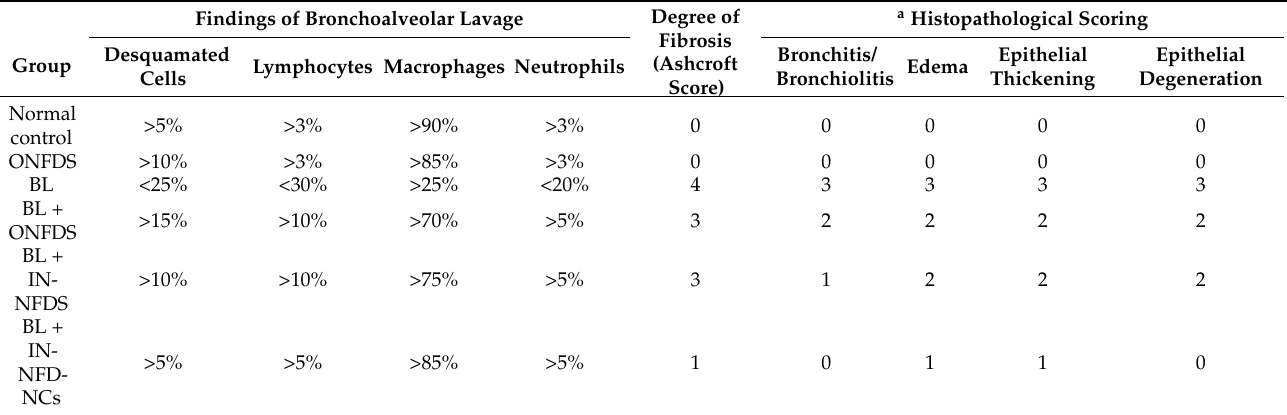
Table 8. The findings of bronchoalveolar lavage, degree of fibrosis (Ashcroft score) and histopathological scoring. Findings of Bronchoalveolar Lavage Degree of Group